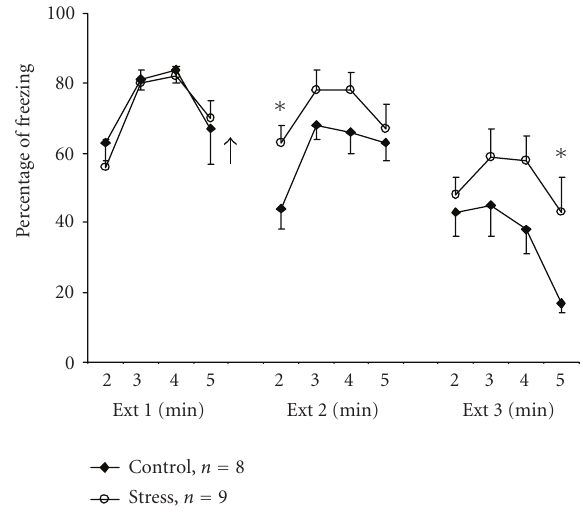
Figure 1: Stress impairs extinction of contextual fear conditioning. Rats were given 3 mild foot shocks in the conditioning chamber. On the next day, the rats were placed in the extinction (Ext) chamber for 5 minutes and no shock was administered (Ext 1; the last 4 minutes are presented since all animals showed high levels of freezing in the first minute). Immediately afterwards, the animals were returned to their home cage (control) or placed on an elevated platform for 30 minutes (stress). Animals were exposed to additional 5 minutes in the extinction chamber, without shocks, on days 3 (Ext 2) and 4 (Ext 3). The stressed animals showed significantly higher levels of freezing compared with the control group during the second minute of Ext 2 ( ∗ ; P < . 05) and the fifth minute of Ext 3 ( ∗ ; P < . 05). Arrow denotes time of exposure to